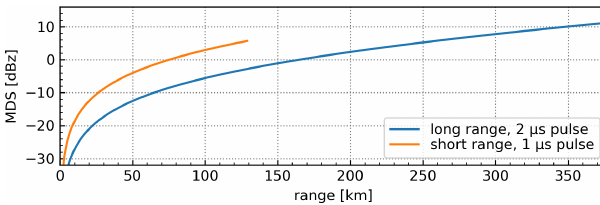
Figure 3. Minimum detectable signal (MDS) for long- and short- range